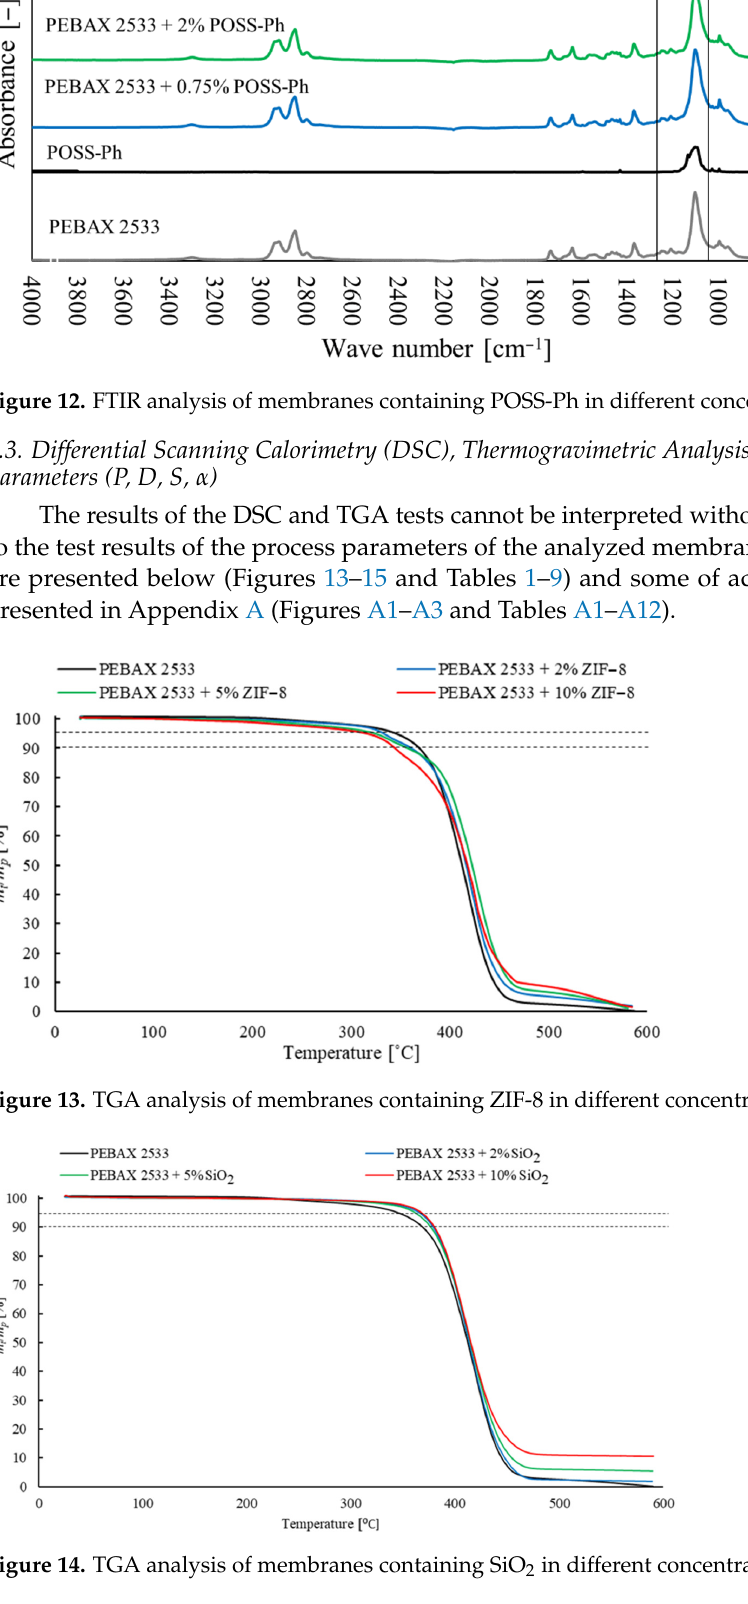
Table 2. DSC analysis results for membranes containing SiO 2 .